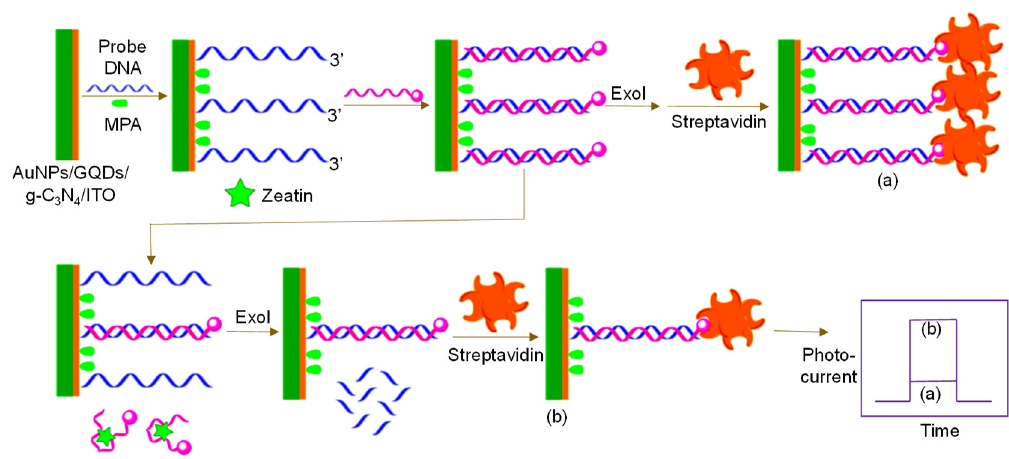
Figure 29. Design of a PEC aptasensor for zeatin determination using GQDs, AuNPs, g-C 3 N 4 and DNA biotin-labeled aptamer [359].